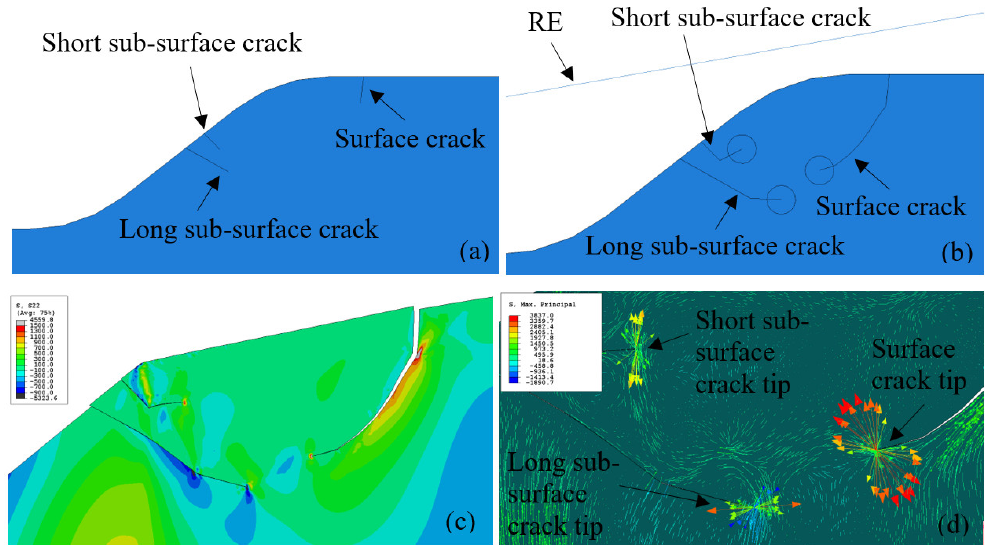
Figure 12. ( a ) Crack implementation in the vicinity of the spall in the initial configuration. Crack lengths: short sub-surface crack—0.02 mm, long sub-surface crack—0.06 mm, surface crack—0.02 mm. ( b ) Crack implementation in the vicinity of the spall in the final stage of propagation. Crack lengths: short sub-surface crack—0.04 mm, long sub-surface crack—0.08 mm, surface crack—0.08 mm. ( c ) S 22 stress field. ( d ) Close-up of the crack tip presents the residual maximum principal stress orientation and